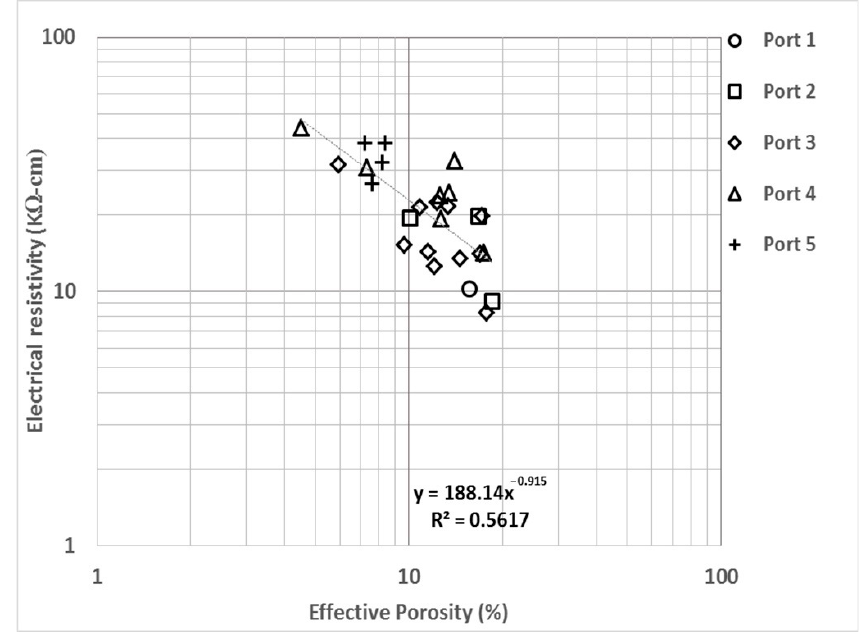
Figure 4. Electrical resistivity (ER) vs. effective porosity (EP).